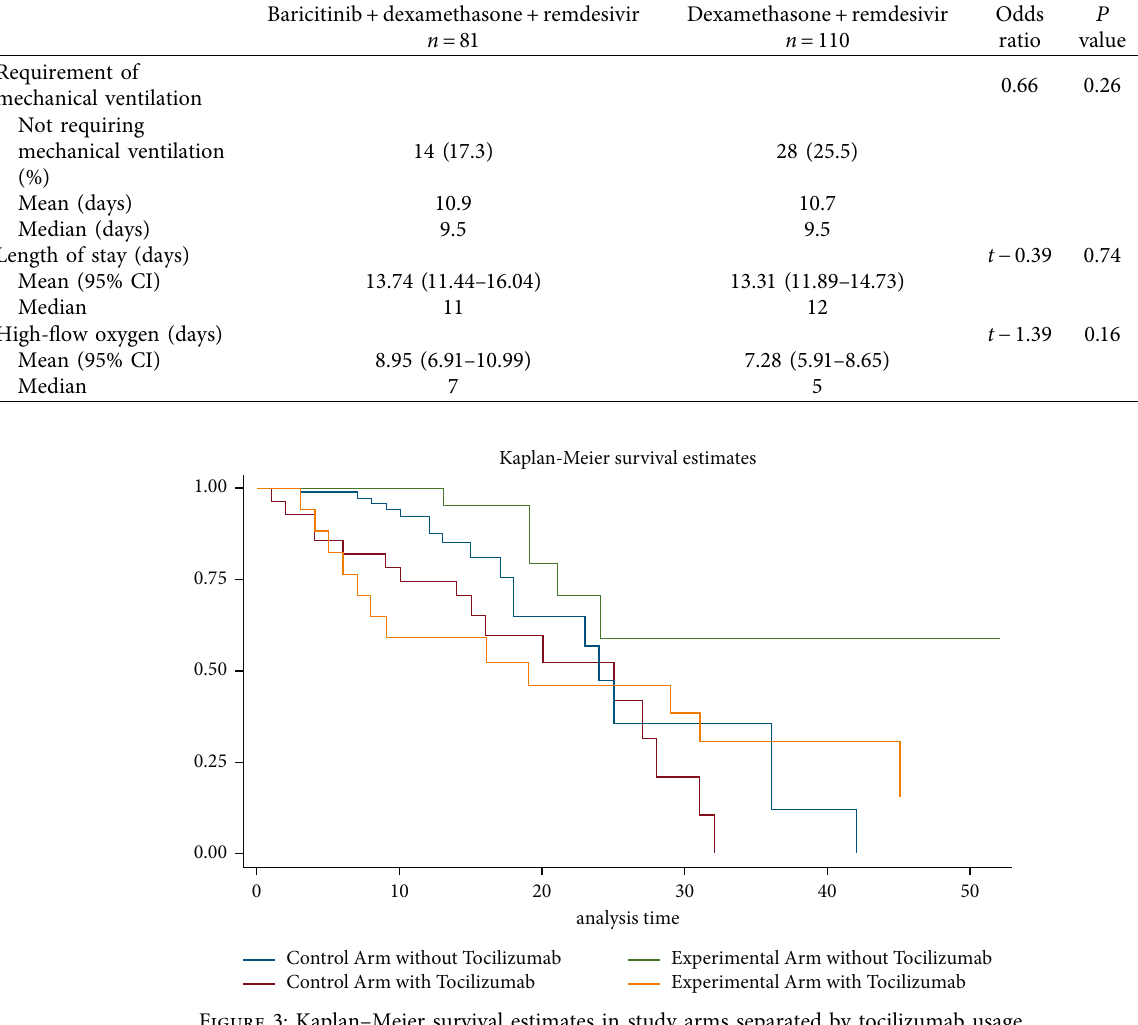
Figure 3: Kaplan–Meier survival estimates in study arms separated by tocilizumab